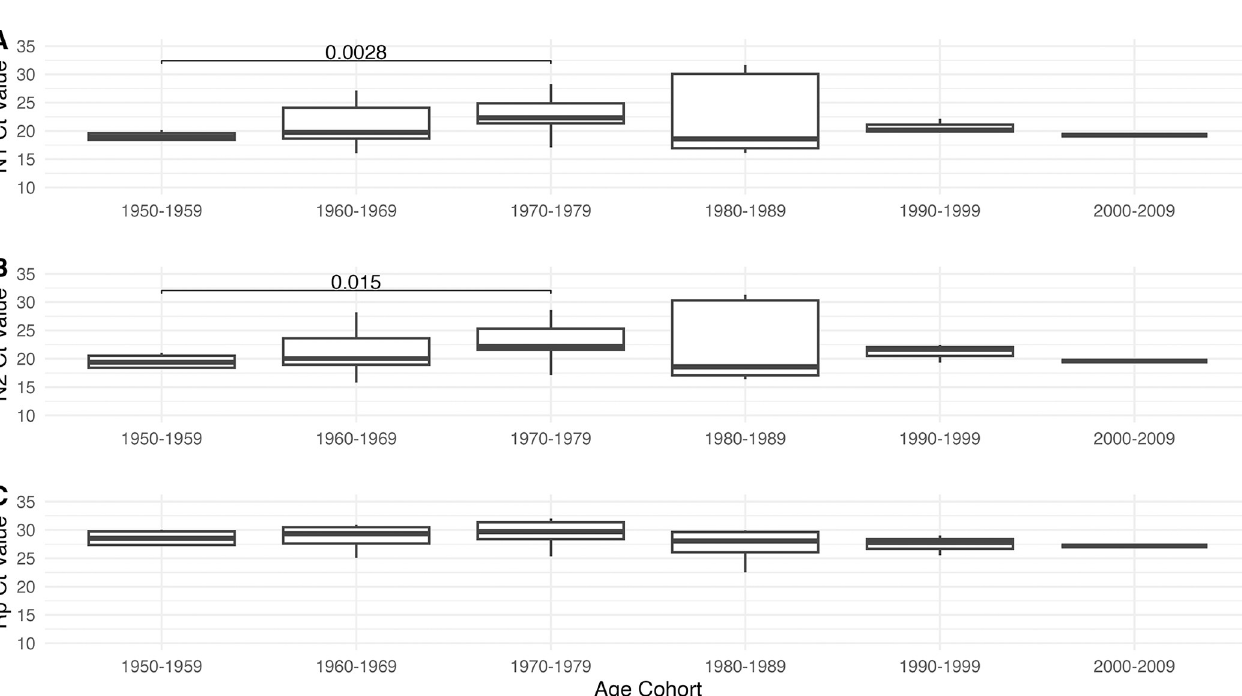
Fig 2. Comparison of birth year by decade and Ct values. Box and whisker plots for each decade cohort. Whiskers indicate maximum and minimum Ct value for each cohort. Horizontal line within box indicates mean Ct value. Significant (p < 0.05) Wilcoxon ranked-sum test significance values are indicated by brackets and listed p-values. A, N1 assay; B, N2 assay; C, Rp assay.